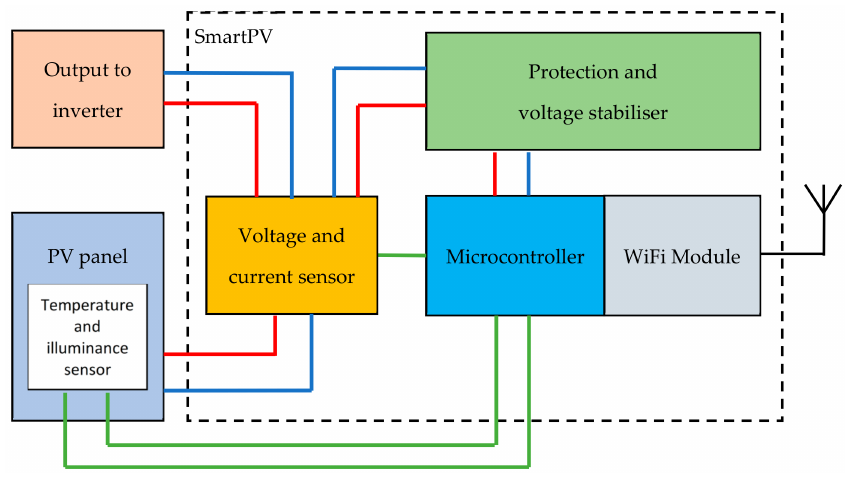
Figure 3. SmartPV block